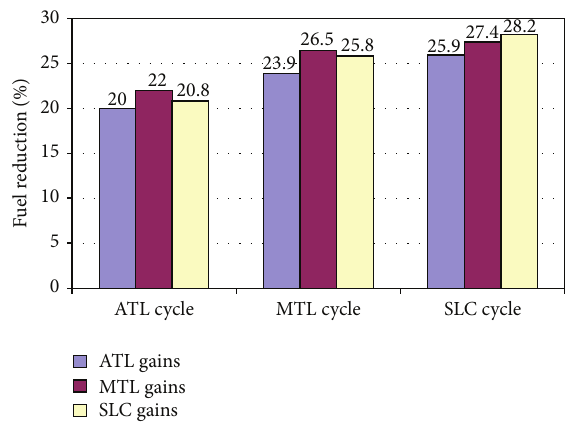
Figure 19: Effect of different gain groups on cycles’ fuel